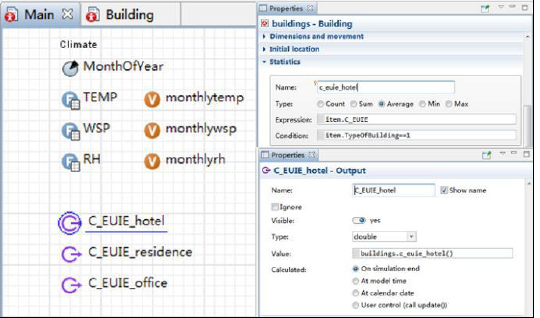
Figure 9. Simulation output of the energy consumption under the climate sub-model on the main panel.